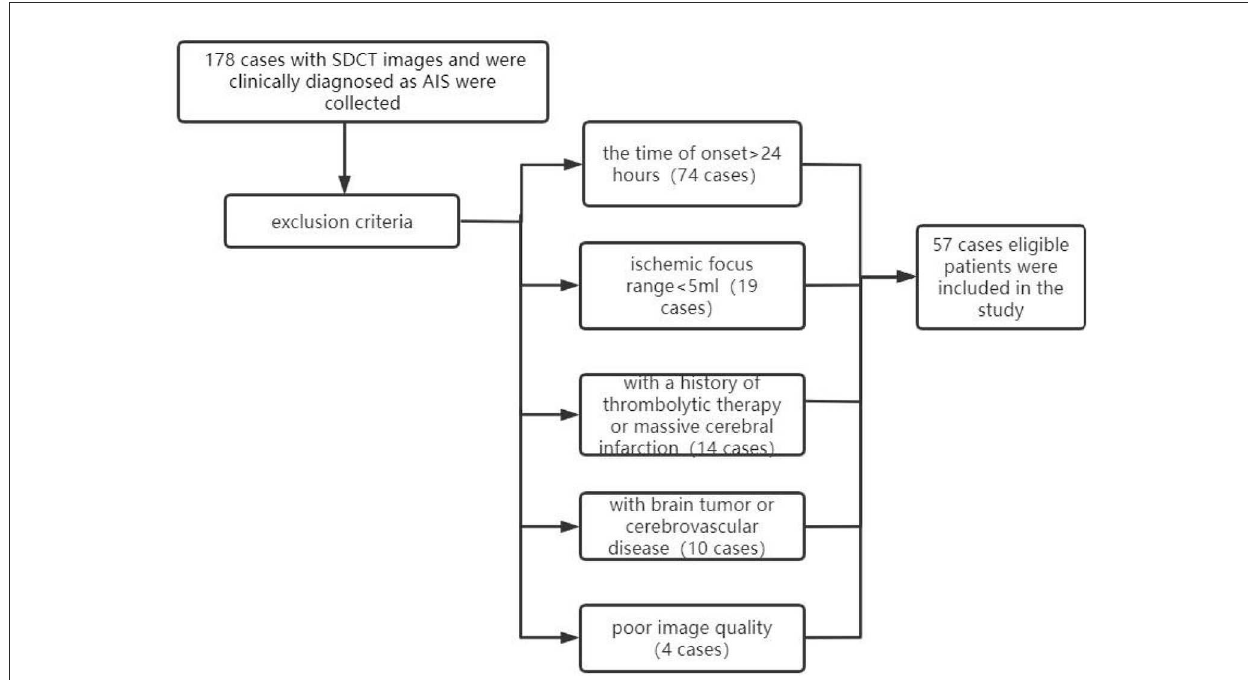
FIGURE1 Flow chart of cases included/excluded in this study. SDCT, dual-layer spectral detector CT; AIS, acute ischaemic